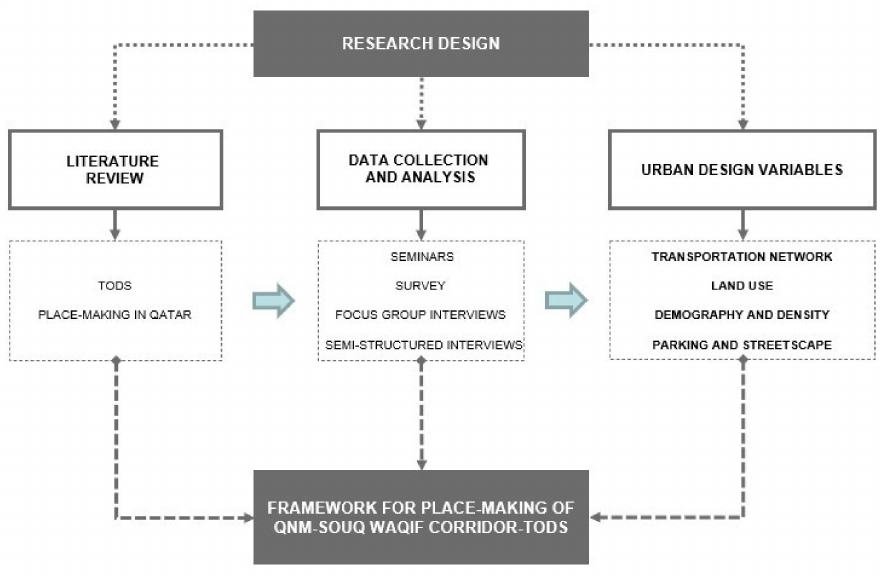
Figure 1. The research